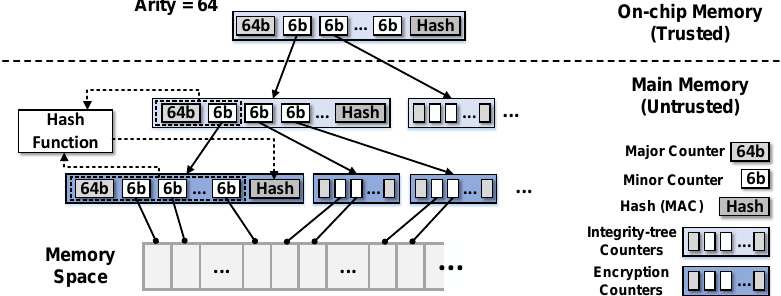
Figure 2. Overall structure of the counter-tree.